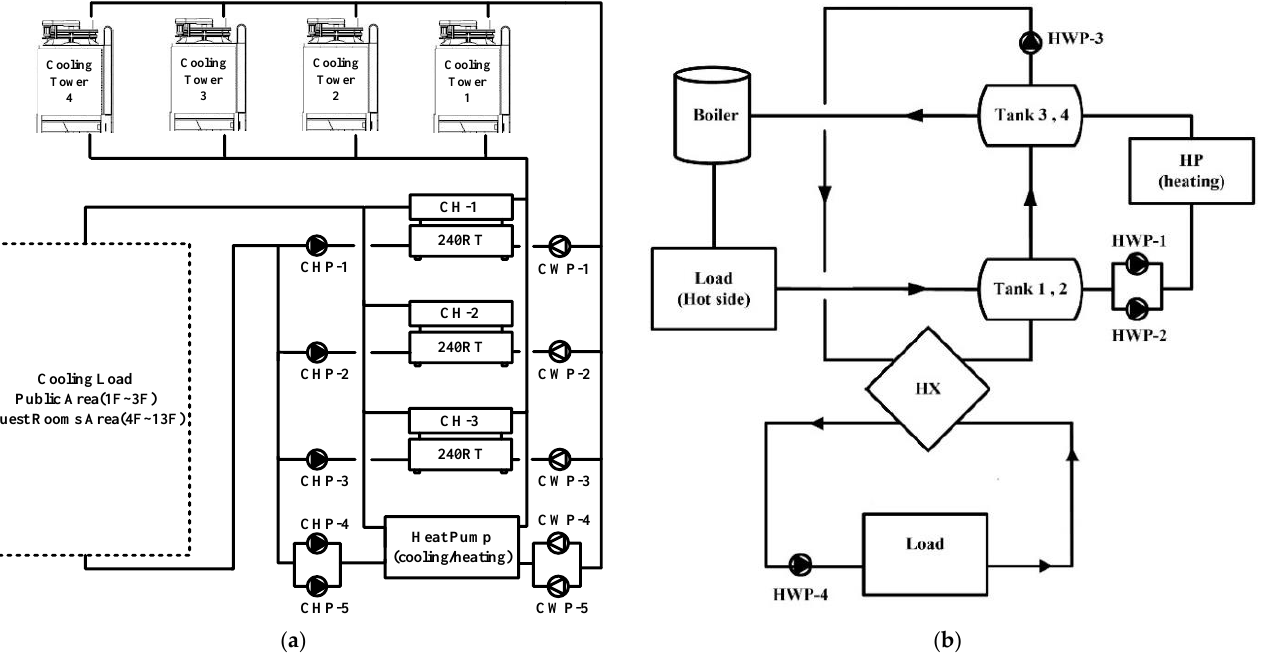
Figure 2. The investigated hotel building: ( a ) HVAC system and ( b ) hot water system. According to the ventilation system, the air-conditioning equipment supplied differs due to the floor space used. The hotel space can be divided into public and guest room areas. The lobby and restaurant from 1F to 3F of the public space use four air handling units (AHU) and several fan coil units (FCU). In addition, the basement also uses FCU, then the guest rooms from 4F to 13F also use FCU. Moreover, four primary air handling units (PAH) are placed on the roof floor to introduce fresh air in order to maintain indoor air quality (IAQ) in the hotel building. Table 1 lists the specifications for the air conditioning ventilation system. Table 1. Specifications for the air conditioning ventilation systems.